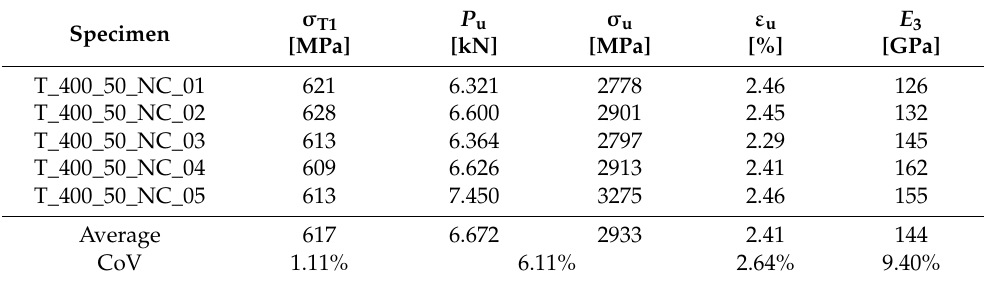
Table 2. Results of tensile tests of control PBO FRCM